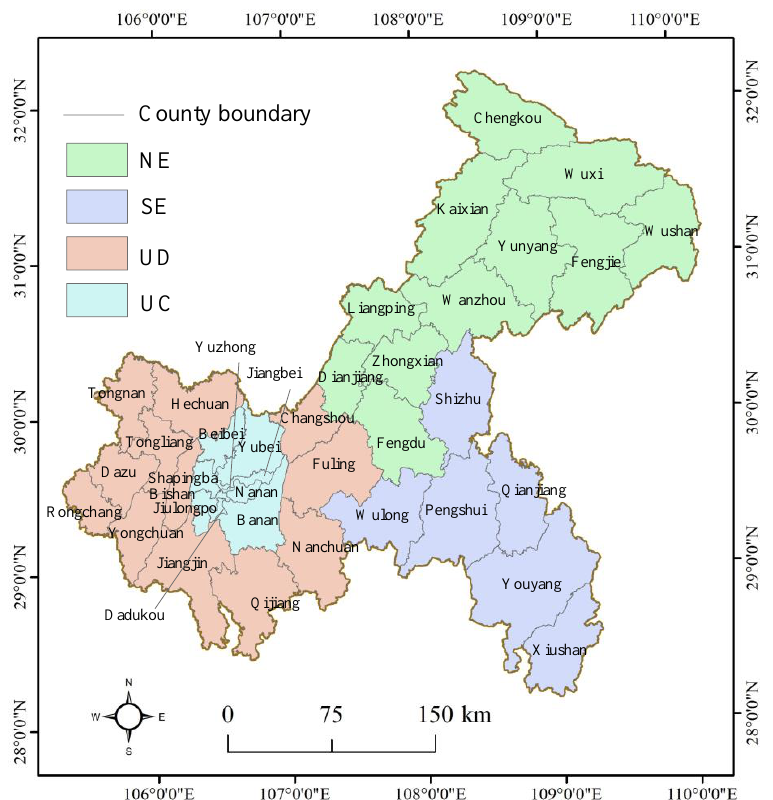
Figure 1. Location of the study area. Note: NE represents the northeastern region of Chongqing; SE represents the southeast region of Chongqing; UD represents the urban functional development region; UC represents the metropolitan region of Chongqing.